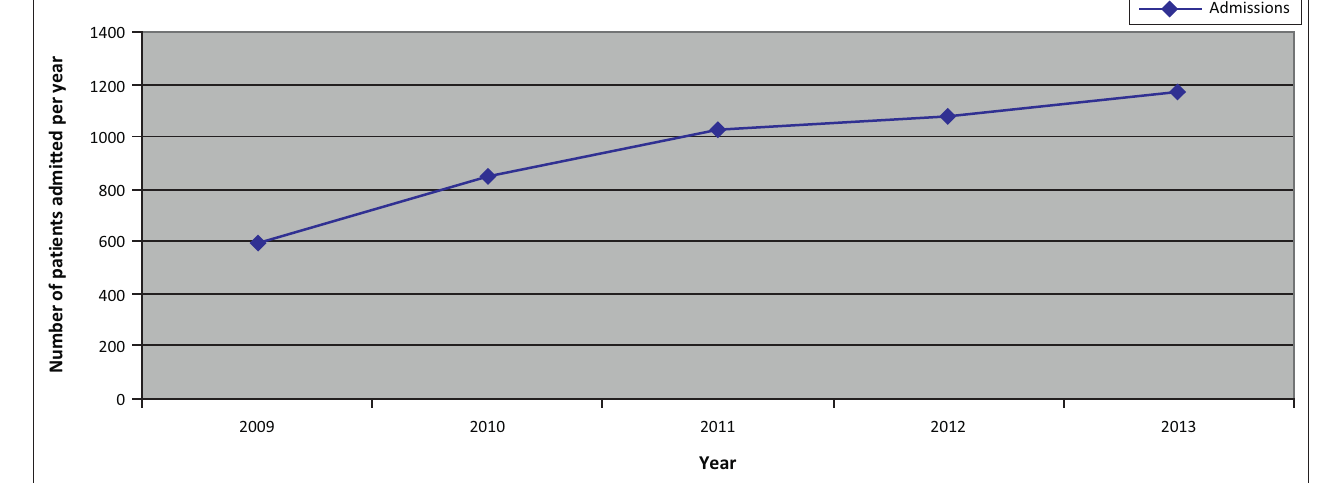
FIGURE 1: Annual admissions during the study period.